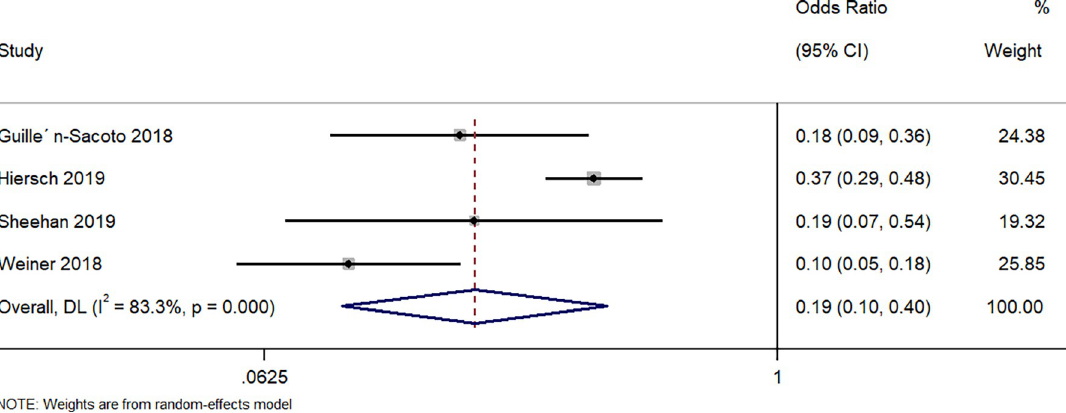
Fig 9. Forest plot showing the difference in neonatal hyperbilirubinemia between women with a singleton pregnancy or twin pregnancy and GDM. NOTE: Weights are from random-effects model.